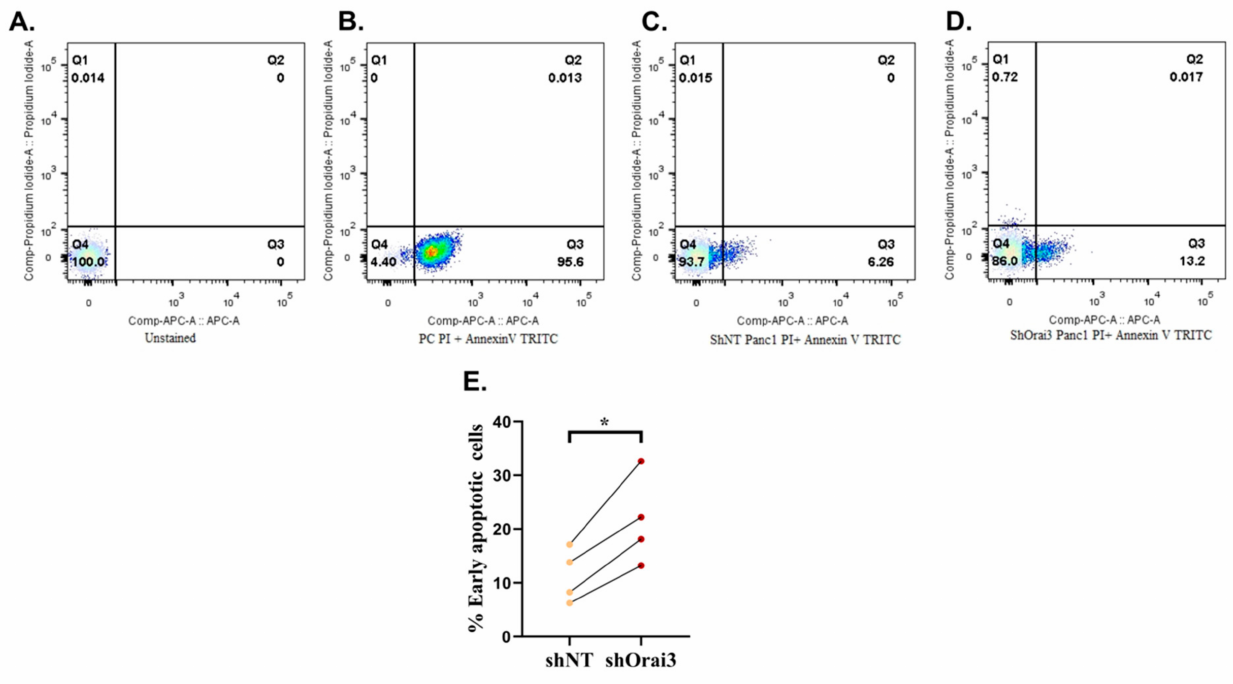
Figure 6. Orai3 regulates basal apoptosis of Panc1 cells. ( A – D ) Representative FACS-based analysis of apoptosis using propidium iodide and TRITC conjugated annexin V for unstained, i.e., negative control Panc1 cells ( A ); positive control Panc1 cells ( B ); shNT Panc1 stable cells ( C ) and shOrai3 Panc1 stable cells ( D ). ( E ) Quantitative analysis of % early apoptotic cells in shNT and shOrai3 Panc1 stable cell lines from 4 independent experiments. Data presented as mean ± S.E.M. Paired t -test was performed for statistical analysis. p -value < 0.05 was considered as significant and is presented as